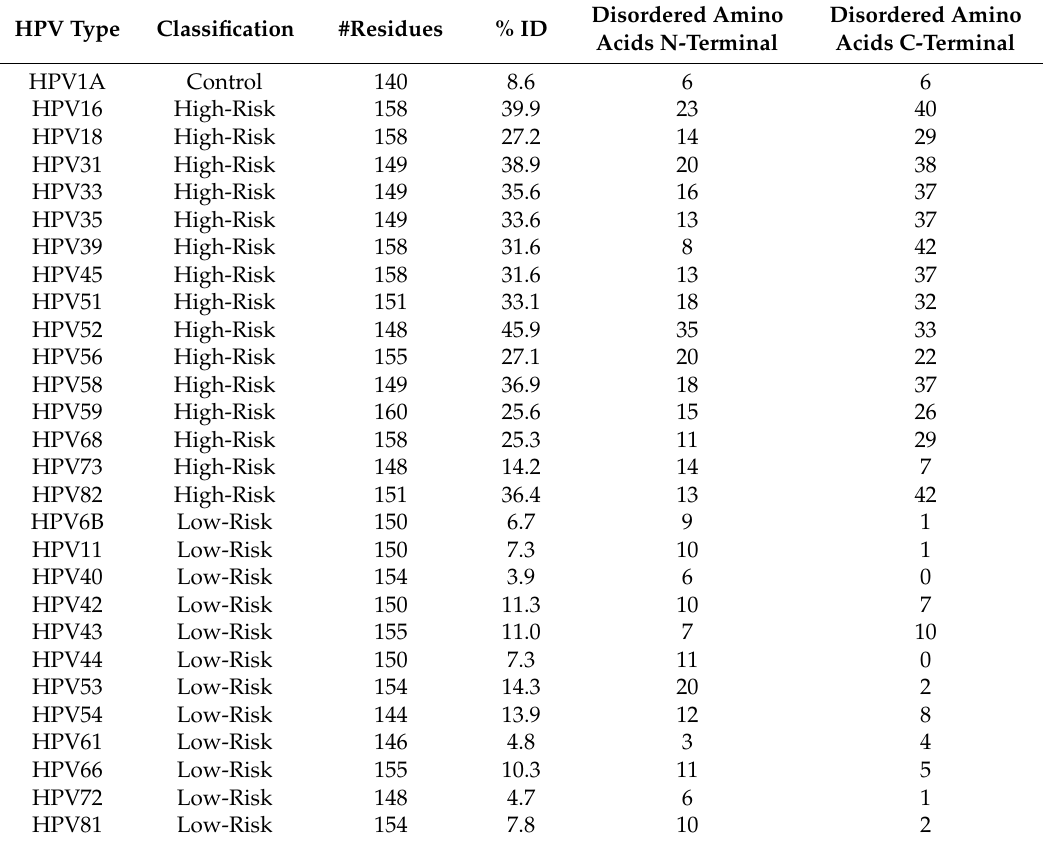
Table 1. Number of disordered amino acids and general percentage of intrinsic disorder in E6 proteins. HPV